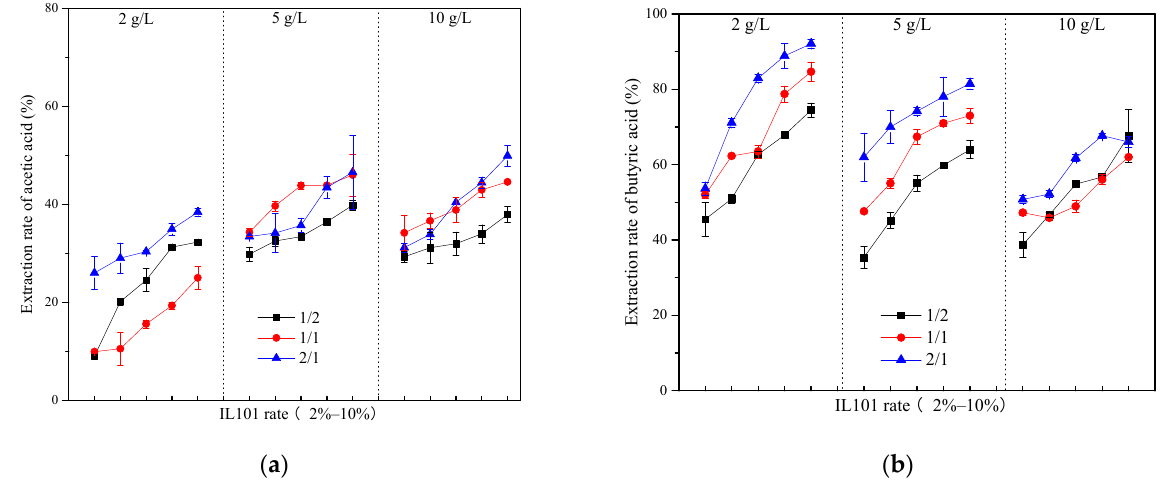
Figure 3. Effect of ratio of IL addition and S/F on extraction efficiency at different VFA concentration ( a ) acetic acid; ( b ) butyric acid).